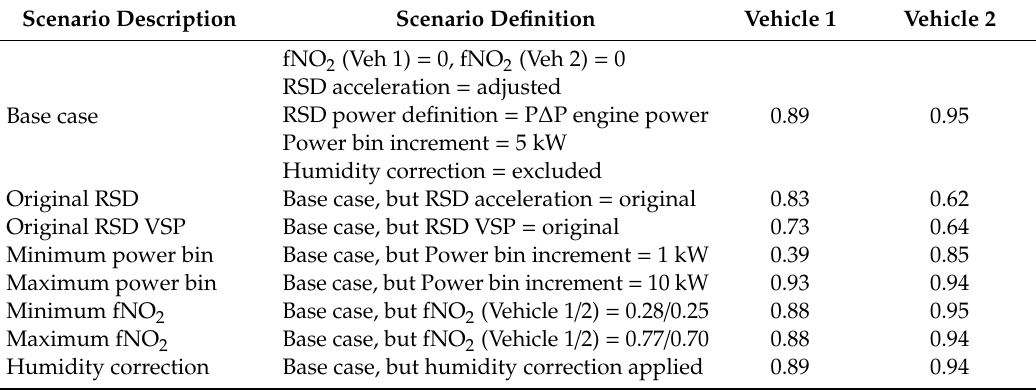
Table 2. Weighted correlation coe ffi cients for di ff erent